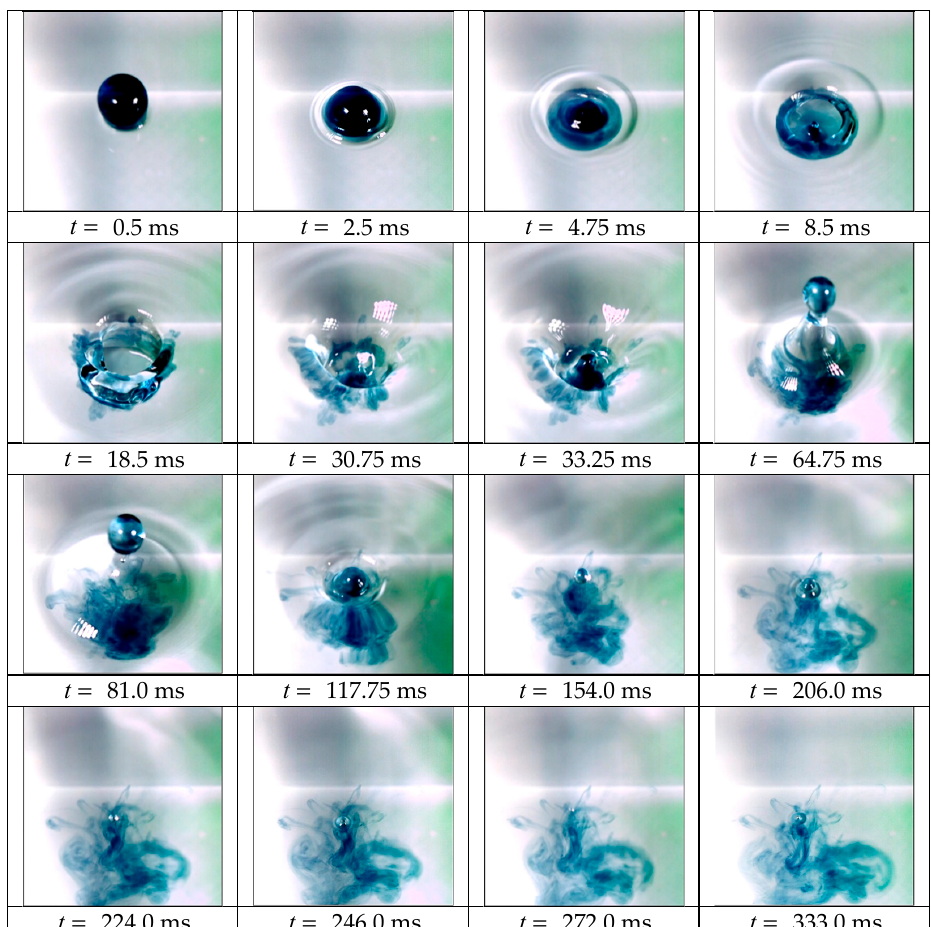
Figure 8. Top view of the flow produced by a slow falling drop of an aqueous ink solution diluted at ratio 1:800 coalescing with tap water in the transitional mode ( D = 4.3 mm, U = 1.0 m/s, E σ = 4 mkJ, E k = 20.8 mkJ, Re = 4300, Fr = 24, We = 60, Bo = 2.5, Oh = 0.0018, R E = E k / E σ = 4.95, R W = 7.2 × 10 − 6 , shooting rate is 4000 fps).